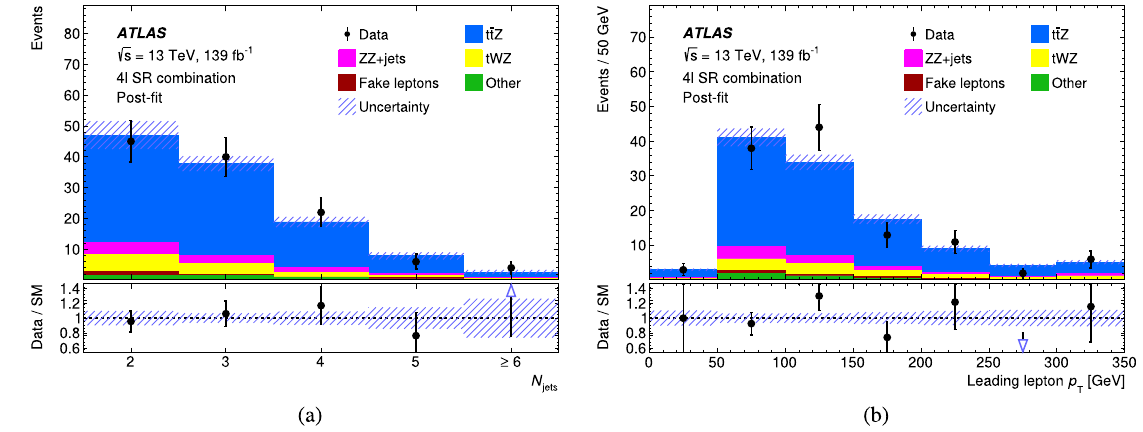
Fig. 5 Post-fit distributions of a N jets and b the p T of the leading lep- ton in the combination of the tetralepton signal regions. The shaded band includes all sources of statistical and systematic uncertainty after the combined fit. The lower panel shows the ratio of data to the total